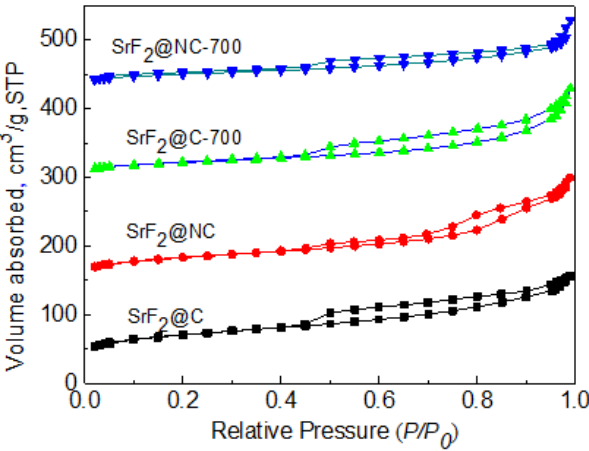
Catalysts 2019 , 9 , x FOR PEER REVIEW 8 of 14 obtained for SrF 2 @C, SrF 2 @NC, SrF 2 @C-700, and SrF 2 @NC-700. Based on the XRD patterns, the Figure 8. The X-ray diffractograms for SrF 2 catalysts and the standard profile of SrF 2 (PDF #88-2294). Figure 8. The X-ray di ff ractograms for SrF 2 catalysts and the standard profile of SrF 2 (PDF #88-2294).